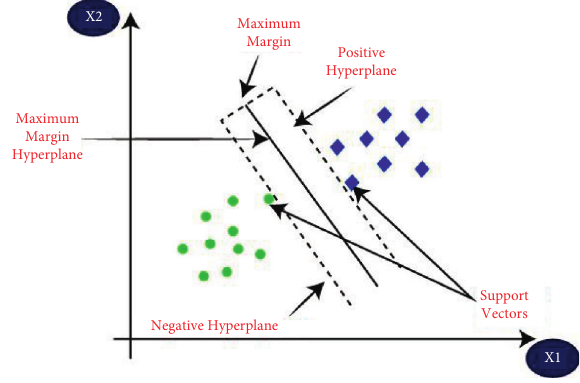
Figure 2: Support Vector Machines (SVM)